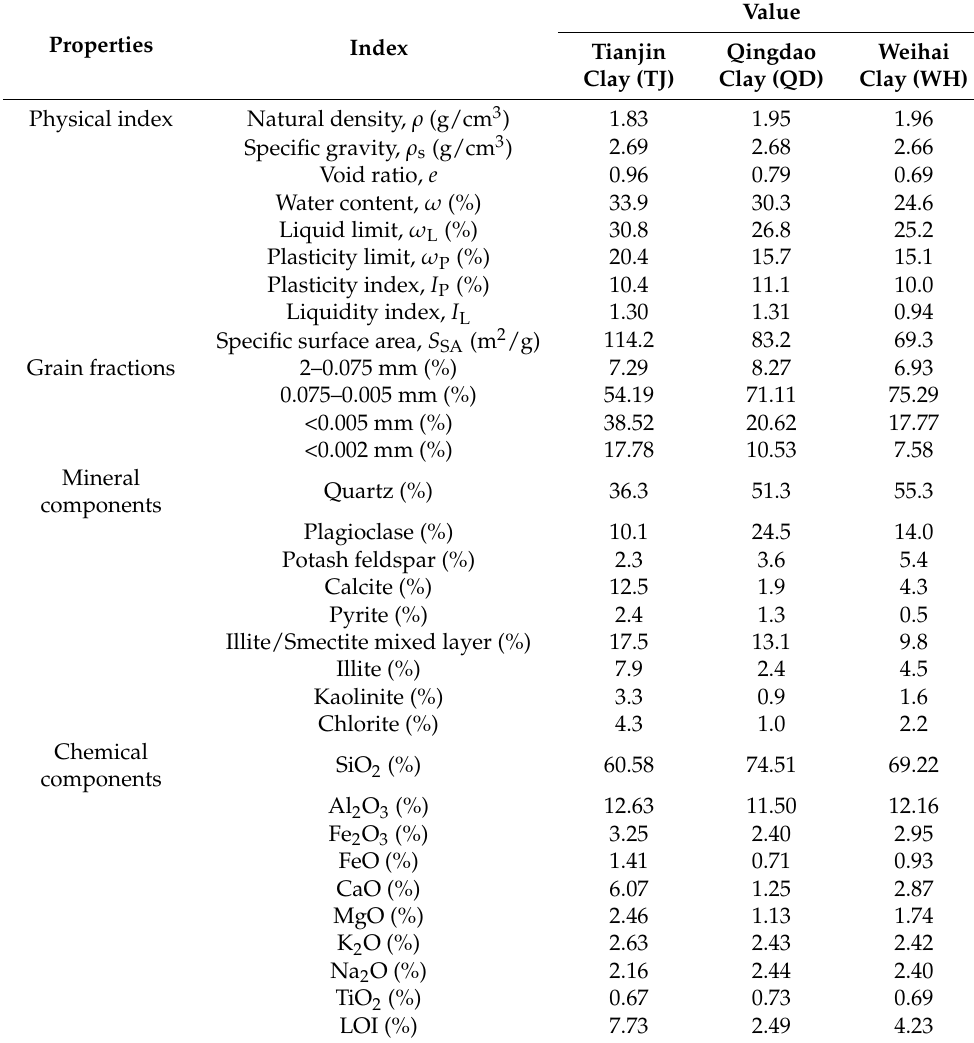
Table 1. Physical parameters, mineral and chemical compositions of soils.